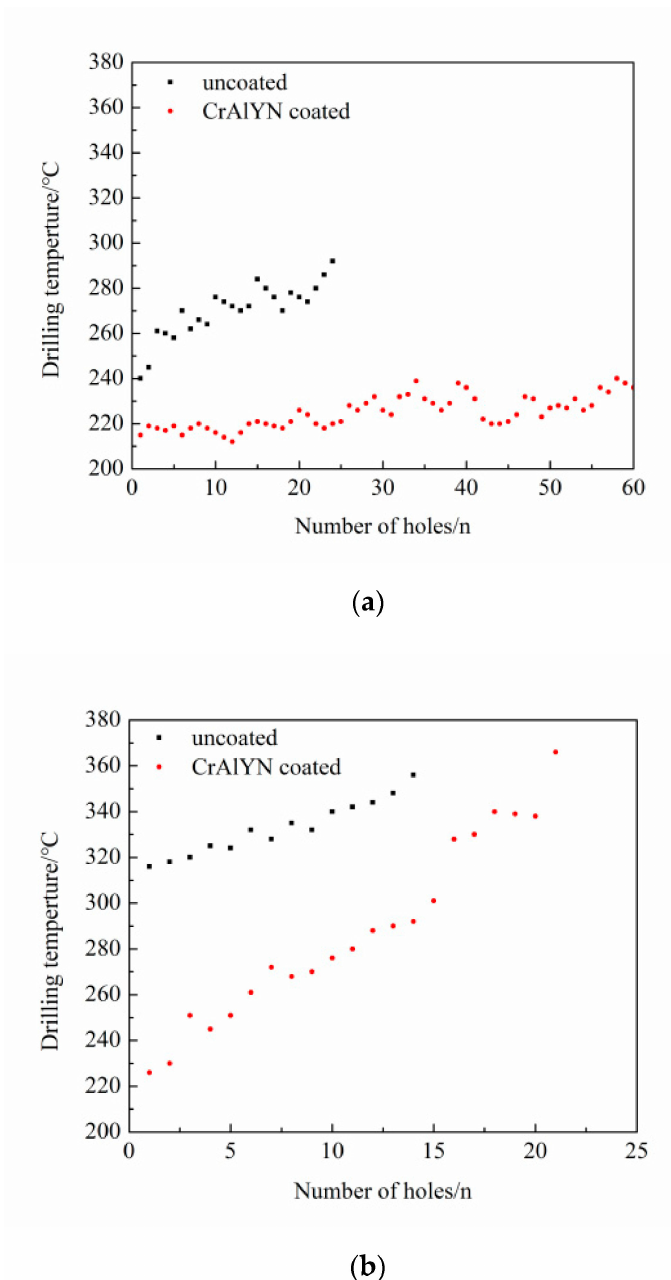
Figure 7. Comparison of drilling temperatures between uncoated and coated bits (drilling depth of 6 mm and drilling feed rate of 0.04 mm/r). ( a ) Drilling temperatures at a drilling speed of 15 m/min. ( b ) Drilling temperatures at a drilling speed of 20